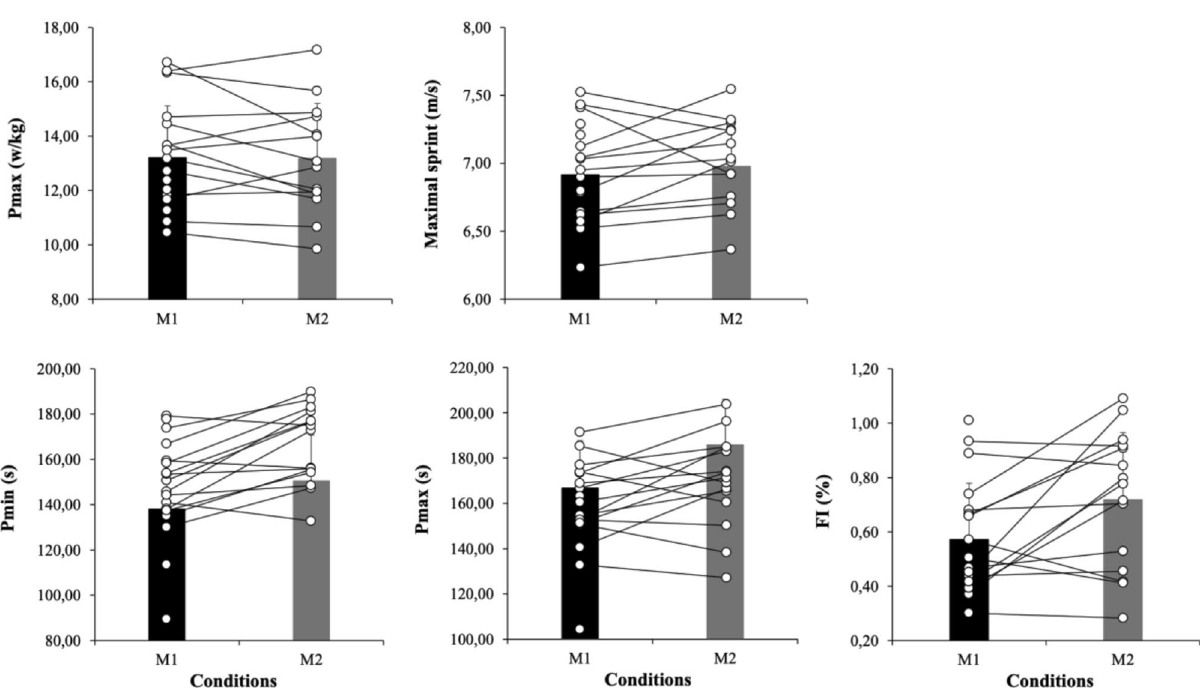
Figure 4. Performance variables (force–power–velocity and RSA test) in moment 1 (M1) and Moment 2